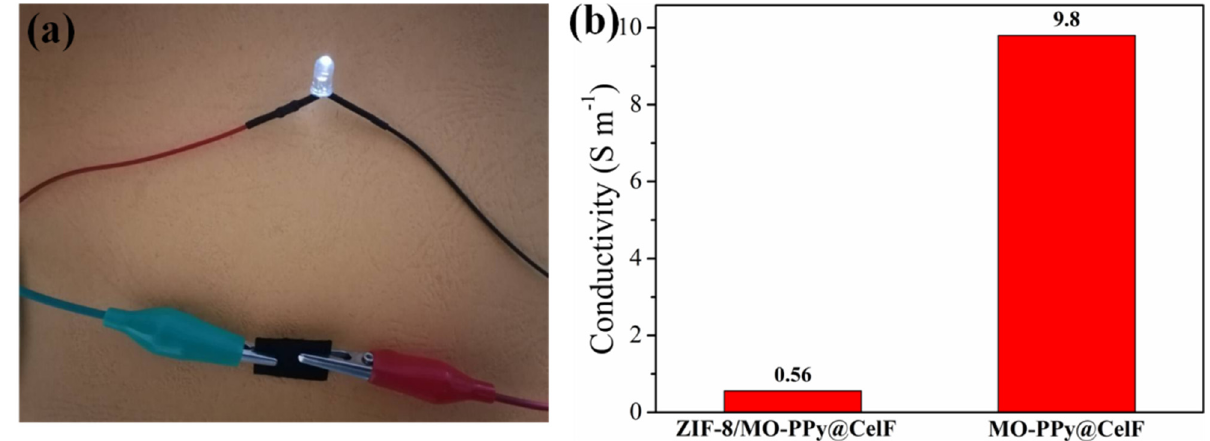
Figure 8. ( a ) Lighting of an LED using the ZIF-8/MO-PPy@CelF with 31.8% ZIF-8 deposition ratio (0.85 mm thick); ( b ) Conductivity values of ZIF-8/MO-PPy@CelF and MO-PPy@CelF.